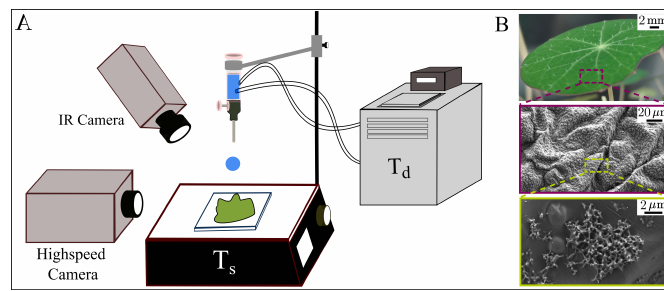
Figure 2. ( A ) a schematic of the experimental set. Cameras film a water drop at temperature T d as it falls from a suspended needle and impacts a Nasturtium leaf heated to temperature T s ; ( B ) images of a Nasturtium leaf taken at different magnifications illustrate the hierarchical